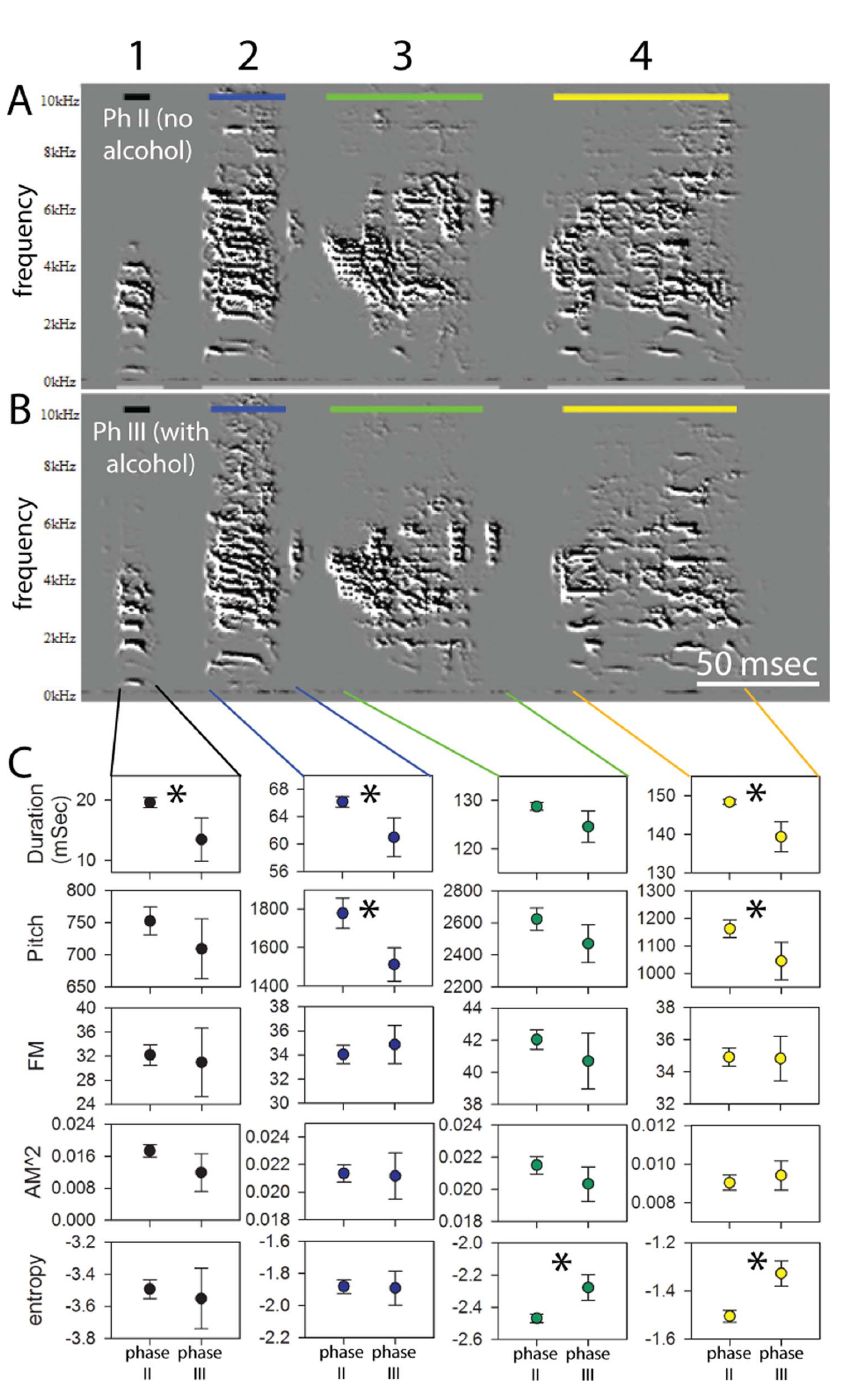
Fig. 7. Effects of alcohol drinking on individual song syllables. Shown are sample spectrograms of single motifs from the same bird in the alcohol group, recorded during (A) Phase II (no alcohol) and (B) Phase III (alcohol); individual syllables are color-coded and labeled 1–4. (C) Plotted are mean values of acoustic features of each syllable during Phases II and III; error bars are Bonferroni-corrected 95% confidence intervals, * indicates significant differences between no alcohol and alcohol